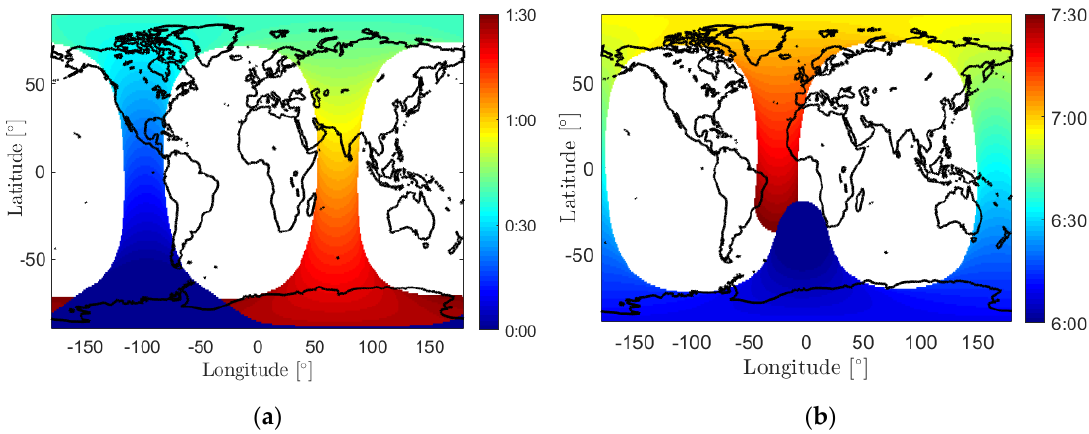
Figure 2. Ascending time of GRACE FO-1 for the day 14 August 2018, ( a ) from 0:00 to 1:30 in GPS time (GPST) and ( b ) from 6:00 to 7:30 in GPST. The almost equal colors around the North and the South Poles are caused by the spherical shape of the Earth and the form of the map.